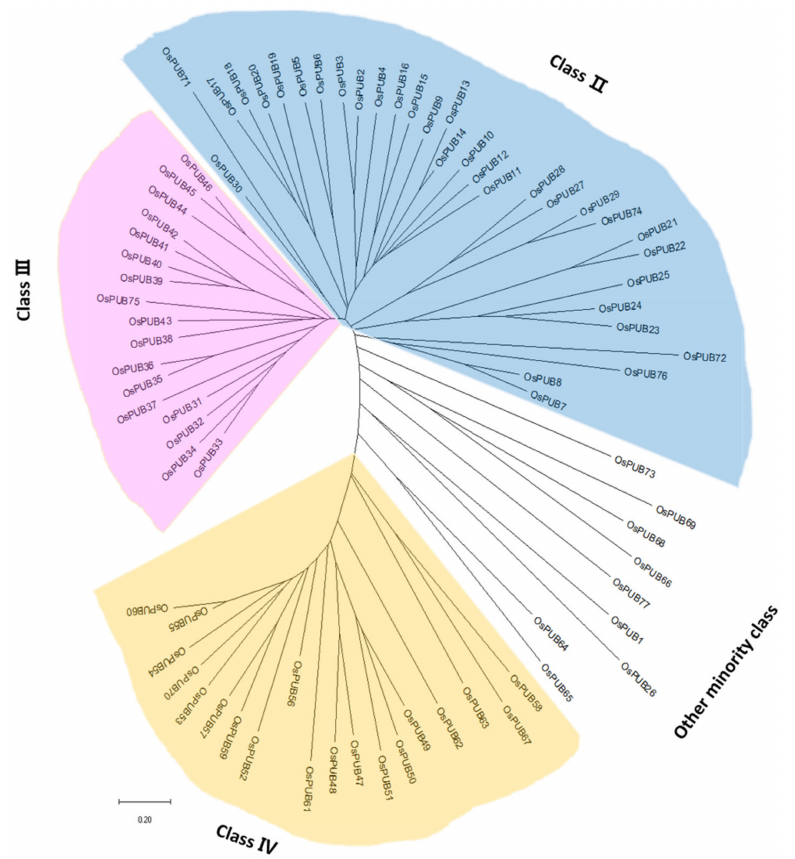
Figure 2. Phylogenetic tree of U-box E3 ubiquitin ligase gene family members in Oryza sativa constructed with the Neighbor-Joining method. The rice U-box gene family is grouped into different classes shown by different colors. Blue color represents Class 2. Pink color indicates Class 3. Yellow color represents Class 4. White color indicates Class 1, Class 5, Class 6, Class 7, and Class